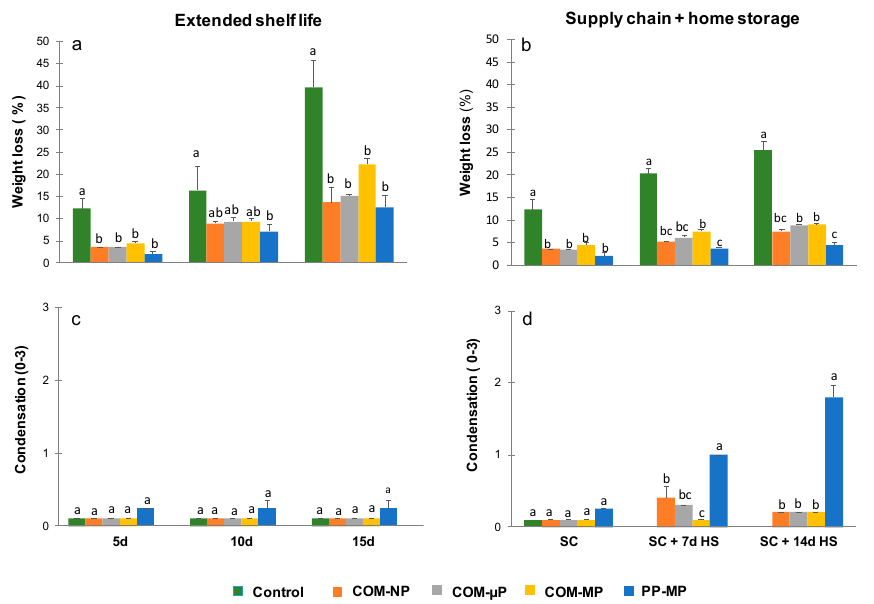
Figure 5. Weight loss and condensation levels in different cucumber packages. Measurements were taken during continuous storage under shelf conditions at 22 °C (Extended shelf life) and after the simulated farm-to-fork supply-chain treatment (2 days at 15 °C + 2 days at 22 °C) plus 1 or 2 weeks of home refrigerated storage at 4 °C (Supply chain + home storage). Figures ( a ) and ( b ) represent weight loss levels, and Figures ( c ) and ( d ) represent condensation levels after extended shelf life and farm-to-fork supply-chain conditions, respectively. Data are means ± SE of 3 replications. Different letters indicate significant differences at p ≤ 0.05. COM—compostable, PP—polypropylene, µP—micro-perforated, MP—macro-perforated, NP—non-perforated.